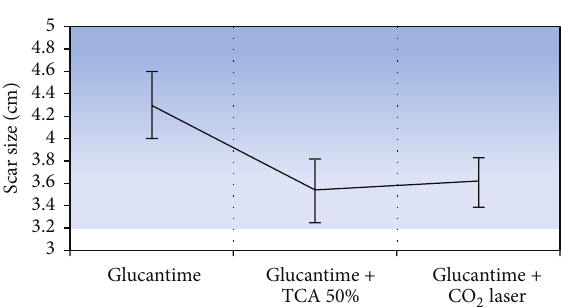
Figure 1: The mean and 95% CI of scar size in three groups.